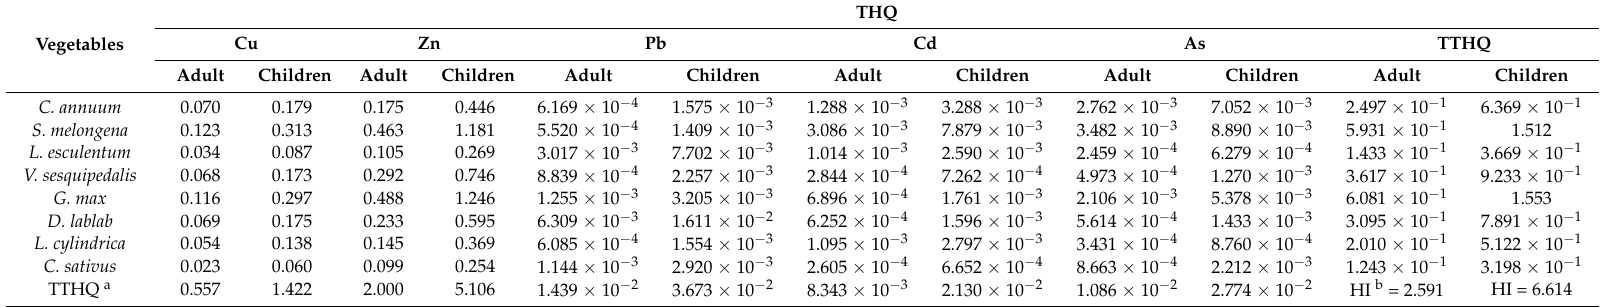
Table 4. Target hazard quotient (THQ; noncarcinogenic risk) of trace elements from consuming vegetables. Vegetables